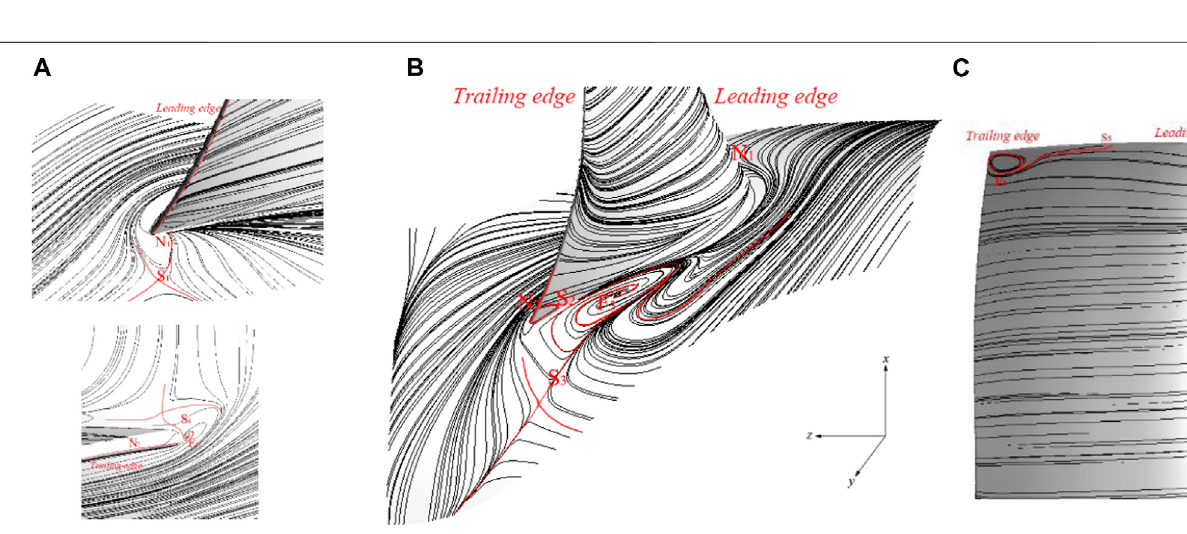
Frontiers in Energy Research |